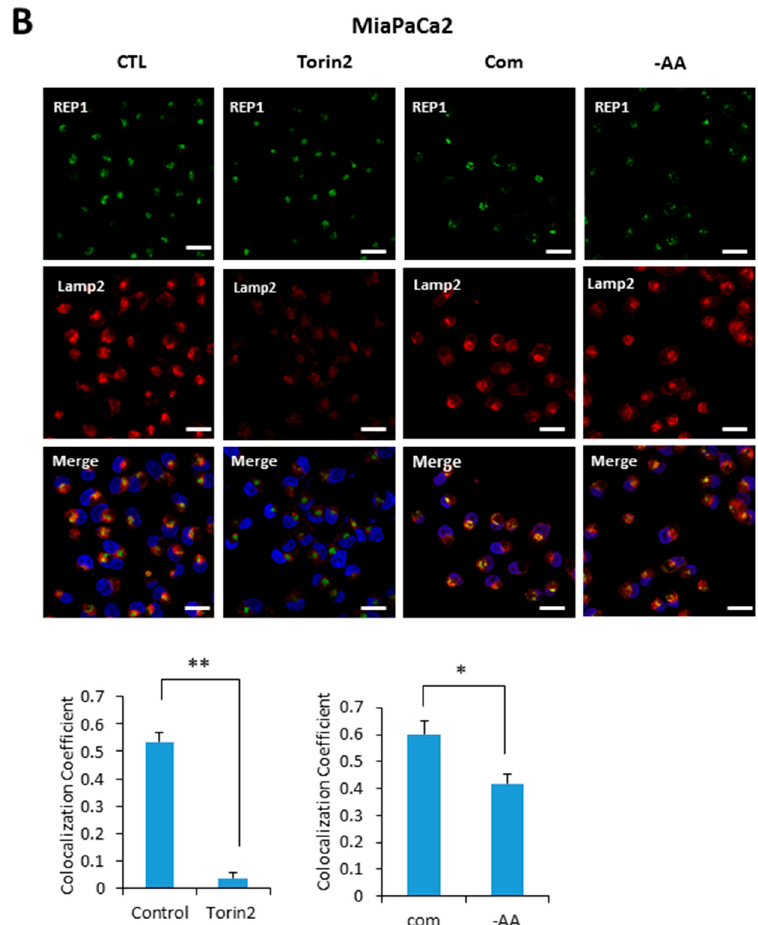
Figure 5. REP1localization is affected by nutrient status and mTOR activity. ( A ) Hela and ( B ) MiaPaCa2 cells were plated and incubated for 24 h, which were further incubated in treatment with Torin2 at 20 nM or replaced with amino acid-deplete media for 4 h. Then the cells were stained with a lysotracker and intracellular fluorescent signals were analyzed by fluorescence microcopy. Co-localization levels were presented as a co-localization coefficient based on image quantification, described in materials and methods. Error bars indicate mean +/ − standard error for n = 3 independent experiments. Statistical significance was determined via Student’s t -test; * p < 0.05.